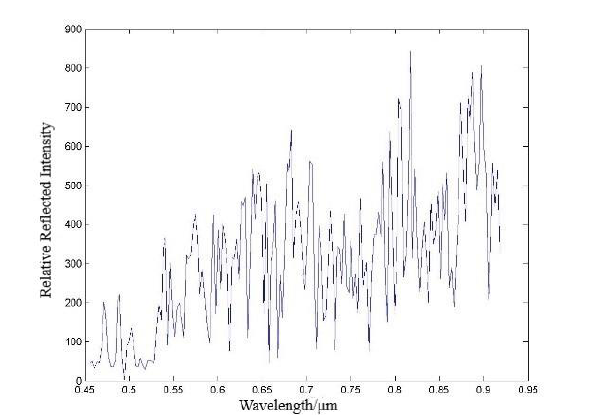
Figure 14. Reconstructed spectrum (rocks)